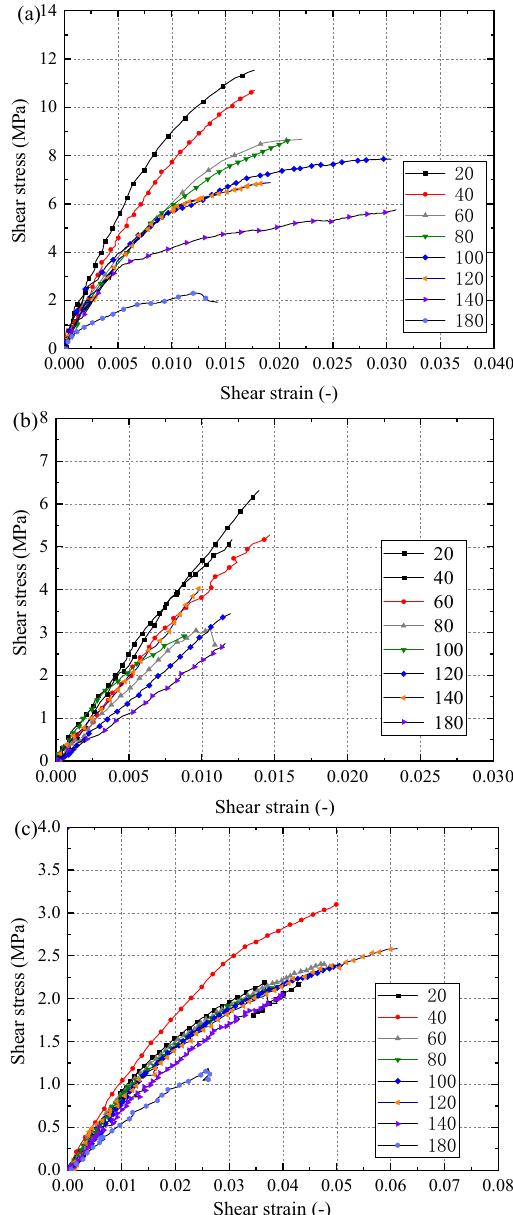
Figure 5. Typical shear stress-strain curves of specimens ( a ) RT; ( b ) RL; ( c ) LR.